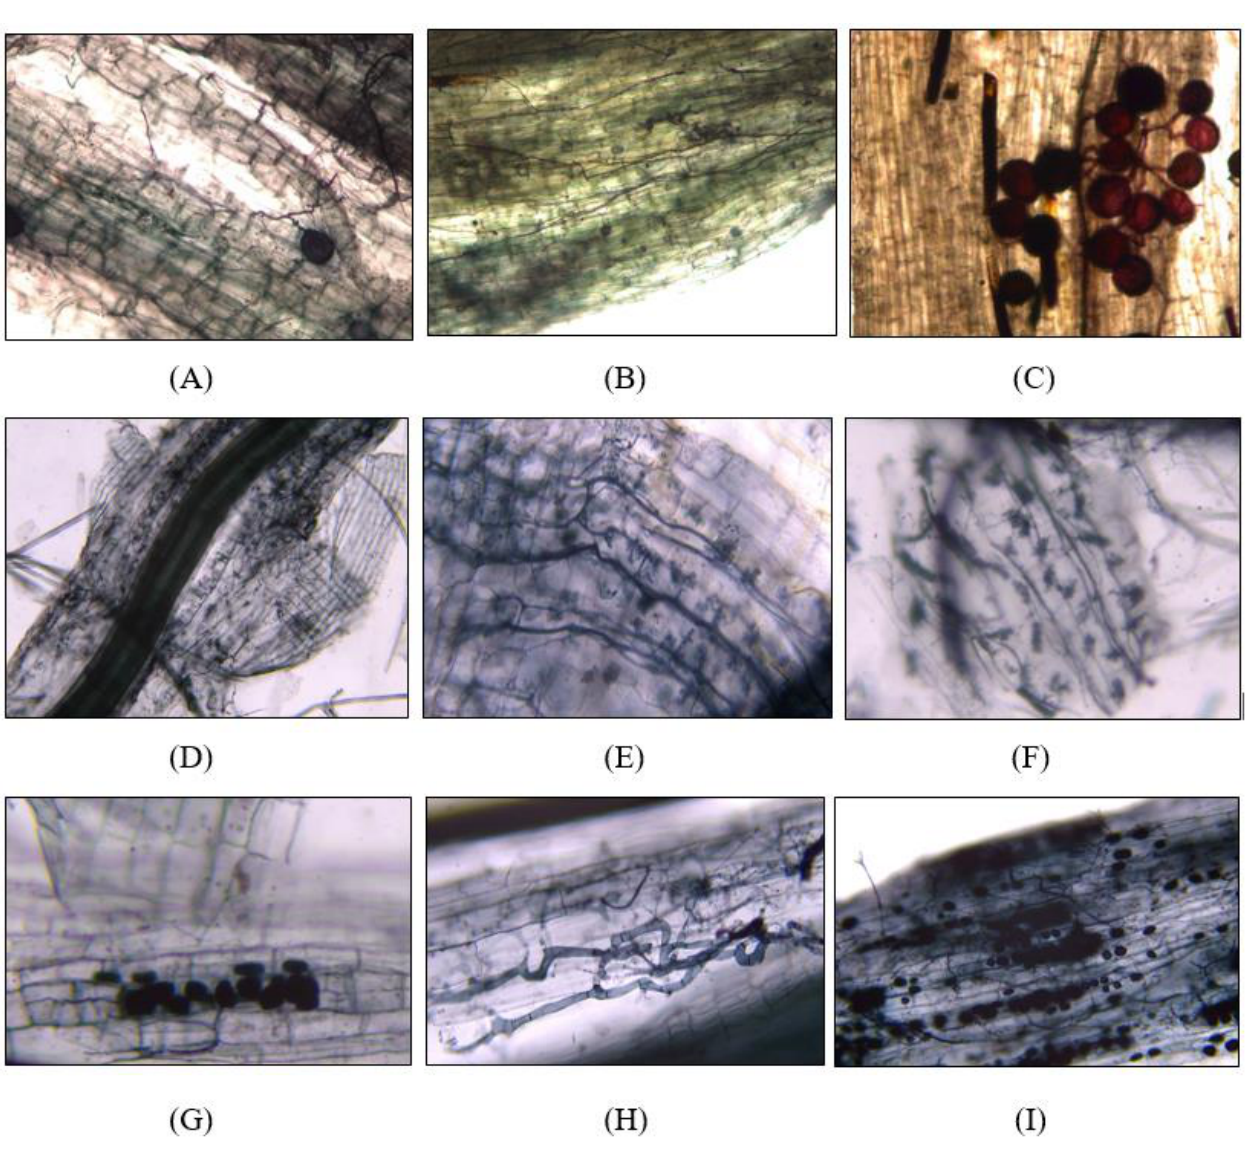
Figure 2. Pictures showing different structures of AMF and DSE colonization observed in root system of native desert plants of Kuwait. Vesicles observed in summer root samples of Acacia pachyceras ( A ), Panicum turgidum ( B ) and Pennisetum divisum ( C ). AMF arbuscules in winter root samples of Cyperus conglomeratus ( D ), Pennisetum divisum ( E ), Stipa capensis ( F ). Microslerotia clusters of DSE in Rhanterium epaposum ( G ), DSE hyphae in Plantago boisseri ( H ), Microsclerotia/resting spores of DSE in Stipa capensis ( I ). All these structures were observed under compound microscope. Source images: Quoreshi et al. [53]. Rodriguez et al. [48] suggest that many plants accept colonization with DSEs to enhance their survival and growth in severe environmental conditions that are triggered by drought, salinity and metal contamination in soils. This has also been reported to increased nutrient uptake for host plants. Such increased nutrient absorption by plants, when colonized by DSEs, may be related to the enhanced C and N absorption and elevated activities of antioxidant enzymes [50]. Many researchers reported that increased nutrient absorption by various plants is observed when inoculated with DSE isolates [50,107,136].